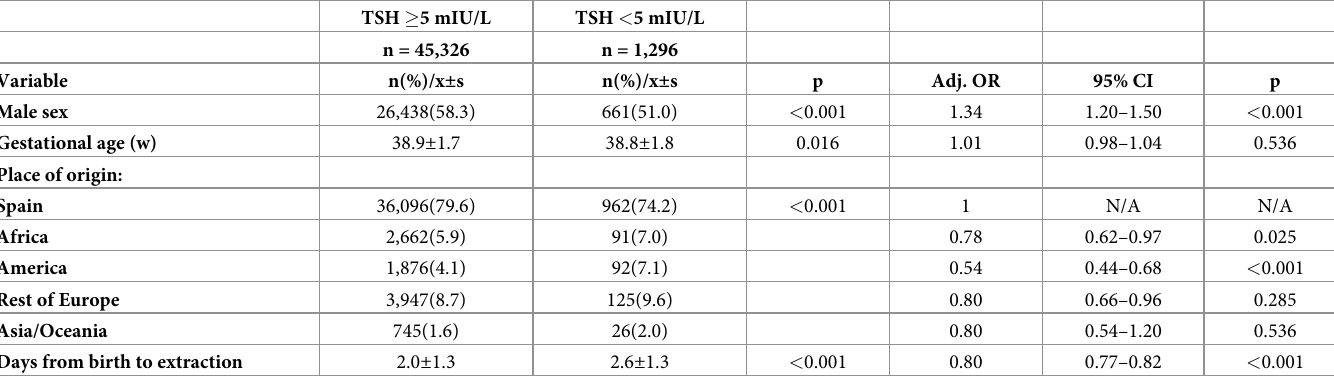
Table 1. Analysis of subclinical hypothyroidism in the Valencian Community